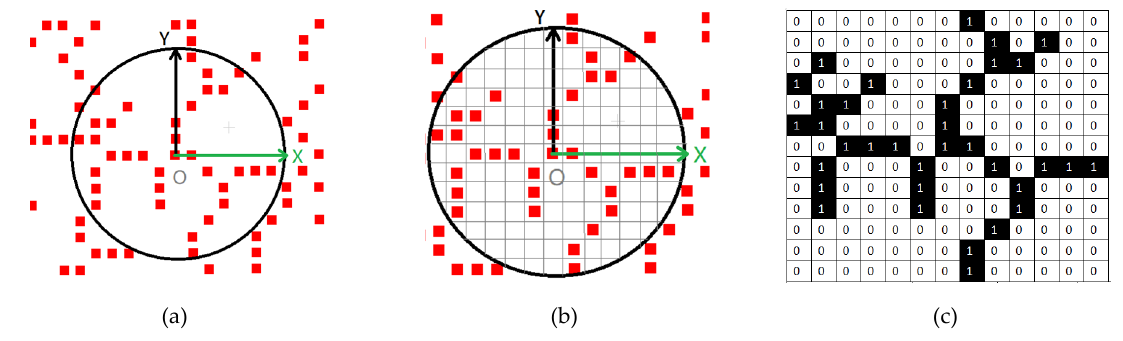
Figure 5. Descriptor generation. ( a ), ( b ) and ( c ) are sketch map of transformed local surface, rasterization and coding.